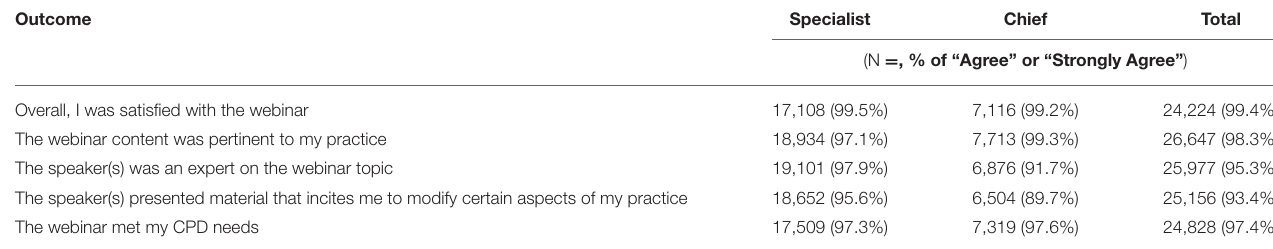
TABLE 3 | Satisfaction data for Specialist and Chief